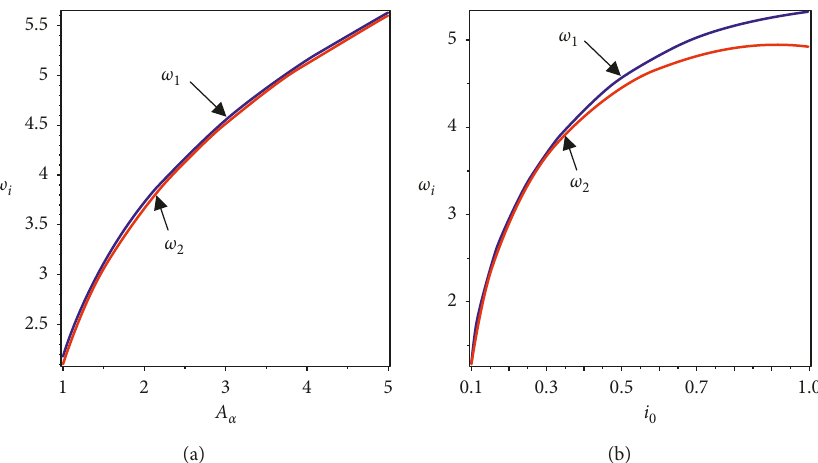
; (b) frequencies obtained under α